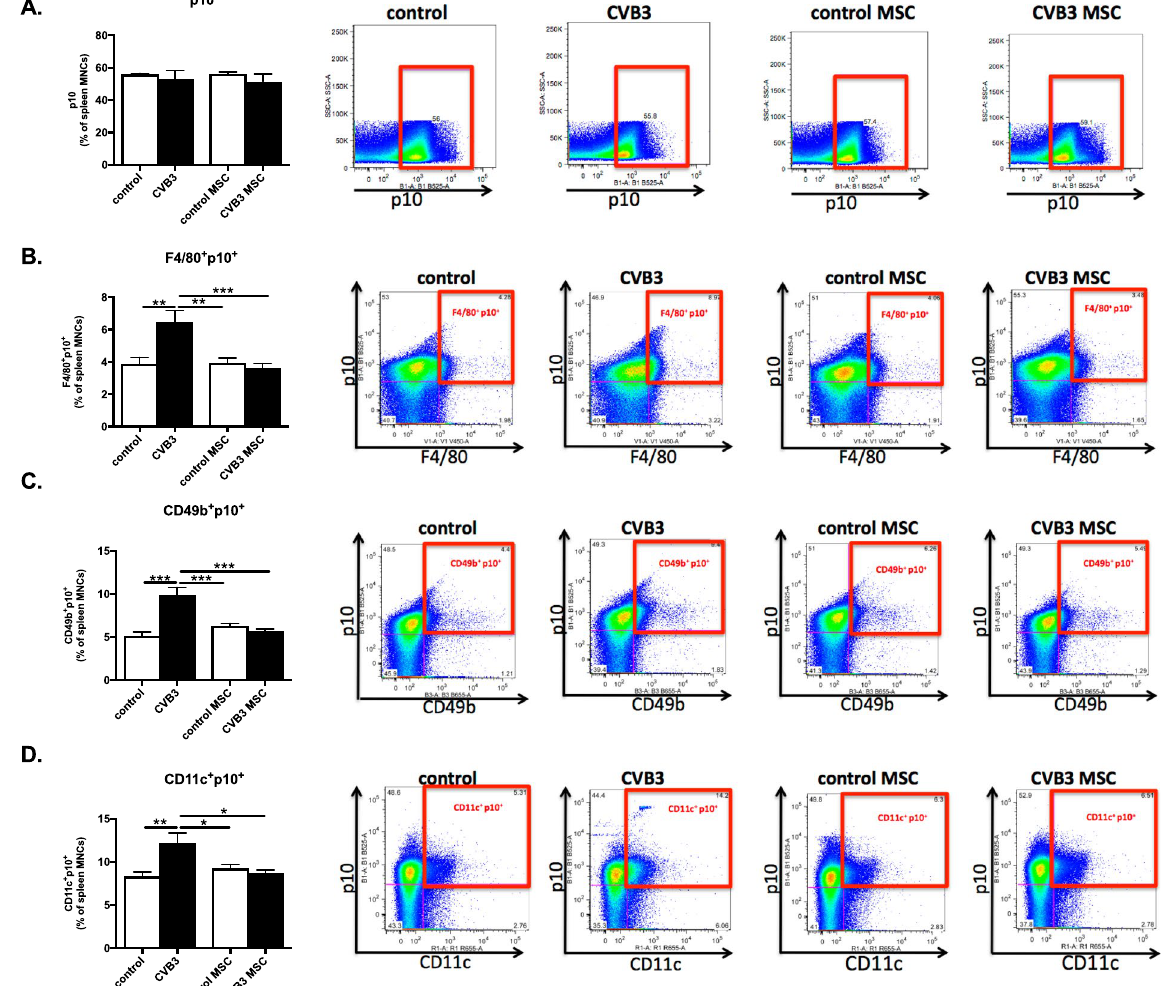
Figure 5. Mesenchymal stromal cells abrogate Coxsackievirus B3-induced Caspase 1 p10 induction in macrophages, natural killer cells, and dendritic cells. ( A ) Bar graphs represent the mean ± SEM of p10 positive splenocytes in control mice (open bar) and CVB3-infected mice (closed bar) injected with PBS or MSC, expressed as the percentage of total MNCs, with n = 8–9/group. The right panel shows dot plots of p10 positive splenocytes of control, CVB3, control MSC, and CVB3 MSC mice, as indicated. ( B ) Bar graphs represent the mean ± SEM of F4/80 + /p10 + in control mice (open bar) and CVB3-infected mice (closed bar) injected with PBS or MSC, expressed as the percentage of total MNCs, with n = 8–9/group, ** p < 0.01 and *** p < 0.001. The right panel shows dot plots of F4/80 + /p10 + positive splenocytes of control, CVB3, control MSC, and CVB3 MSC mice, as indicated. ( C ) Bar graphs represent the mean ± SEM of CD49b + /p10 + in control mice (open bar) and CVB3-infected mice (closed bar) injected with PBS or MSC, expressed as the percentage of total MNCs, with n = 8–9/group and *** p < 0.001. The right panel shows dot plots of CD49b + /p10 + positive splenocytes of control, CVB3, control MSC, and CVB3 MSC mice, as indicated. ( D ) Bar graphs represent the mean ± SEM of CD11c + /p10 + in control mice (open bar) and CVB3-infected mice (closed bar) injected with PBS or MSC, expressed as the percentage of total MNCs, with n = 8–9/group, * p < 0.05 and ** p < 0.01. The right panel shows dot plots of CD11c + /p10 + -positive splenocytes of control, CVB3, control MSC, and CVB3 MSC mice, as